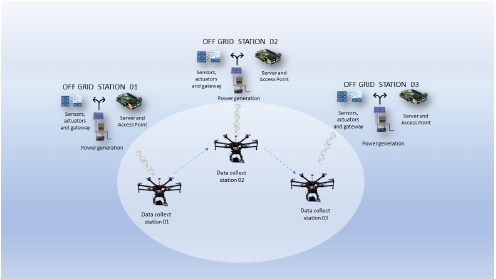
Figure 4. Scenario with off-grid stations and drone displacement.